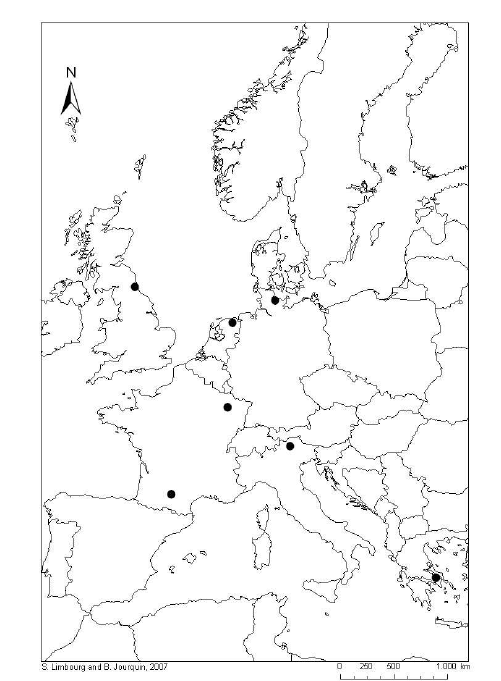
Figure 15. The 7 hubs obtained using data corresponding to the Ward aggregated